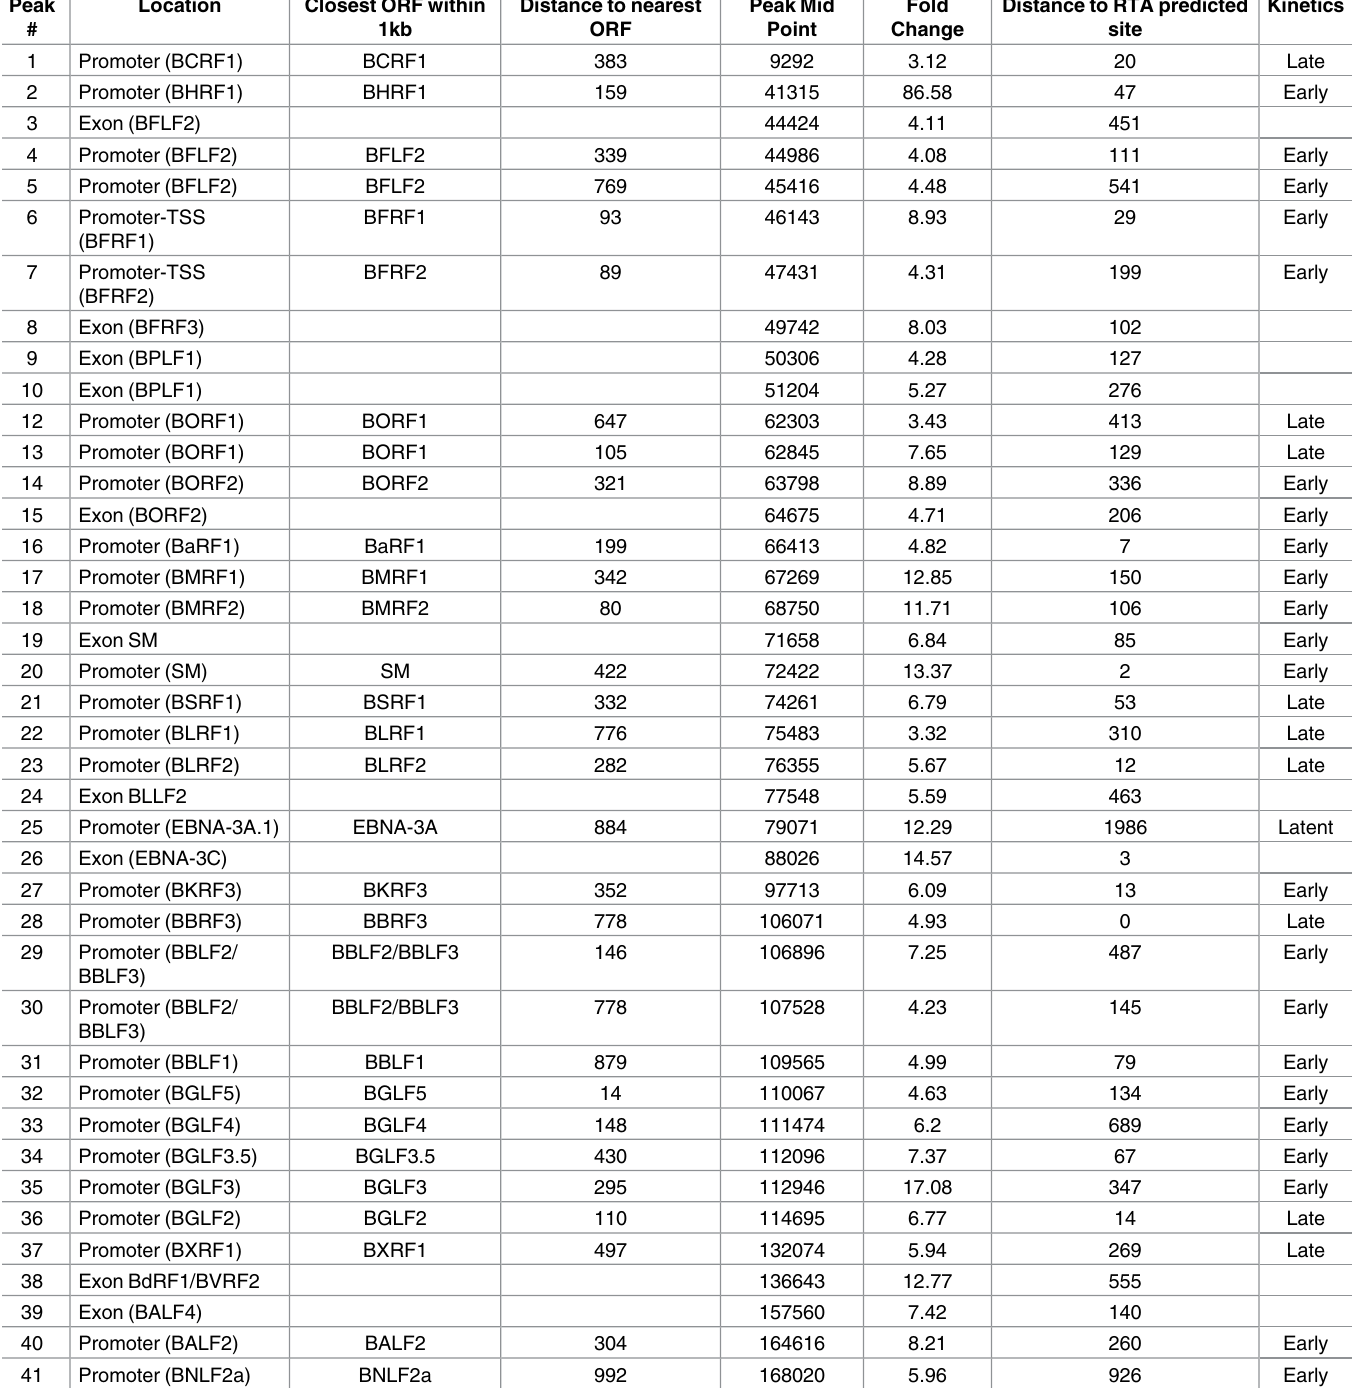
Table 1. Rta ChIP-seq peaks detected during the late phase of the EBV lytic